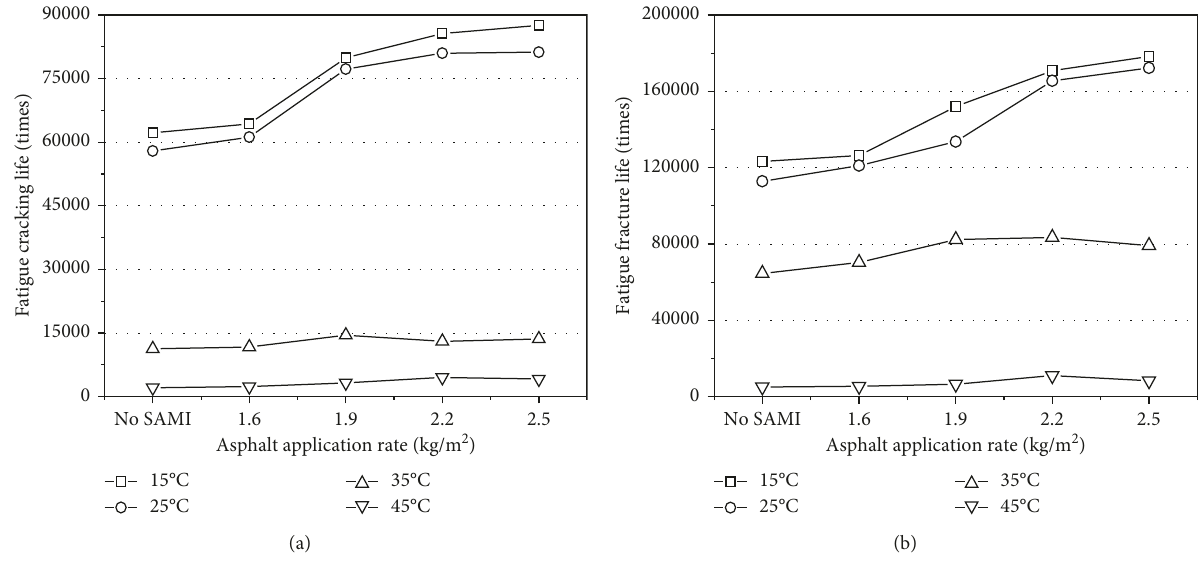
Figure 13: Fatigue cracking test results under the conditions of water bath at different temperatures: (a) fatigue cracking life; (b) fatigue fracture